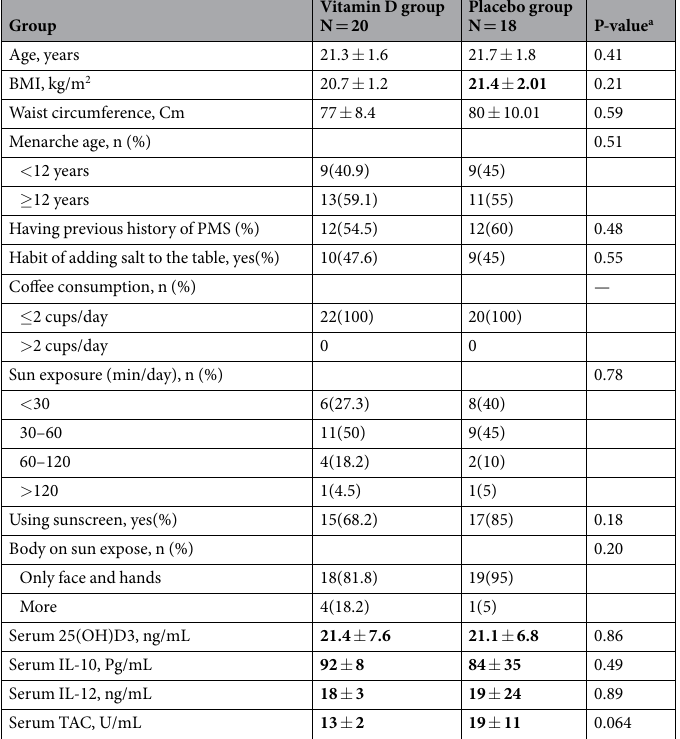
Table 1. Baseline characteristics in the two study groups. a Resulted from independent t-test for quantitative and chi-square test for categorical variables Q uantitative variables: mean ± SD Qualitative variables: frequency (percentage). BMI, body mass index.